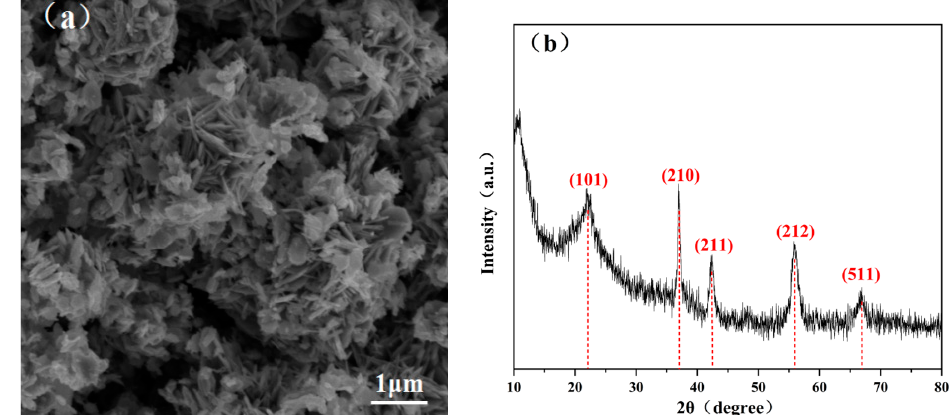
Figure 1. Scanning electron microscope (SEM) image ( a ) and X-ray diffraction (XRD) pattern ( b ) of γ -MnO 2 .